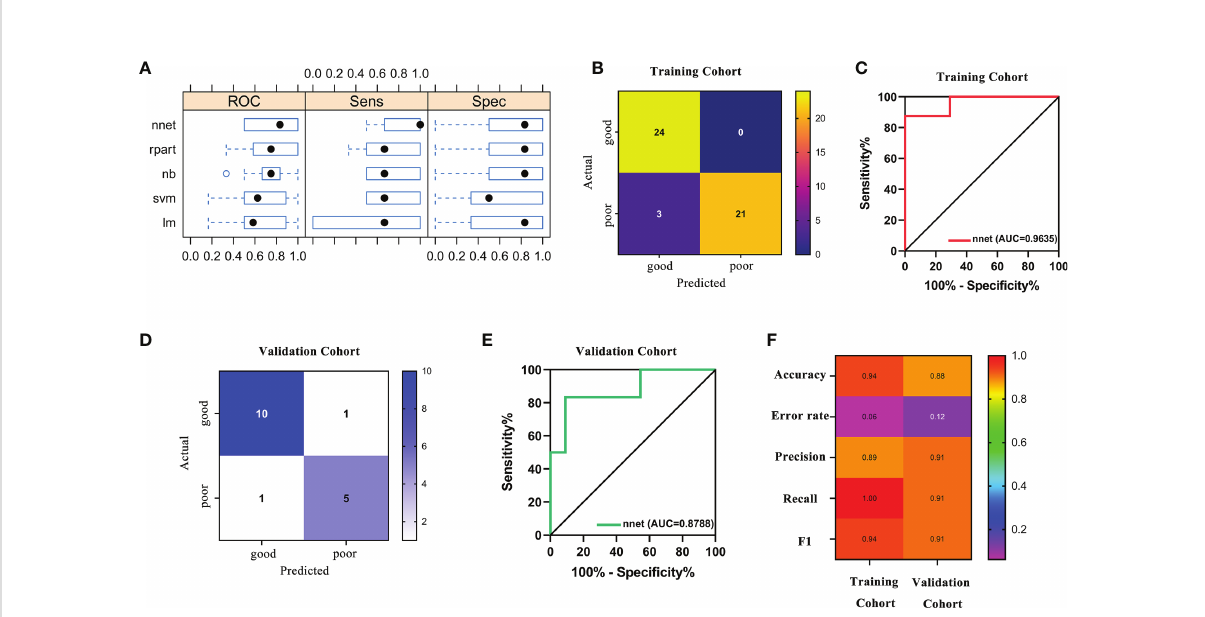
FIGURE 5 Performance of machine learning models based on FIGO risk scores and serum peptide signatures. (A) , comparison of the performance among 5 machine learning methods by cross-validation; (B) , confusion matrix of the classi fi cation results by the nnet model in training cohort; (C) , ROC analysis using the nnet model to discriminate between different outcome groups in training cohort; (D) , confusion matrix of the classi fi cation results by the nnet model in validation cohort; (E) , ROC analysis using the nnet model to discriminate between different outcome groups in validation cohort; (F) , summary of accuracy, error rate, precision, recall and F1 for the nnet model in the training and validation